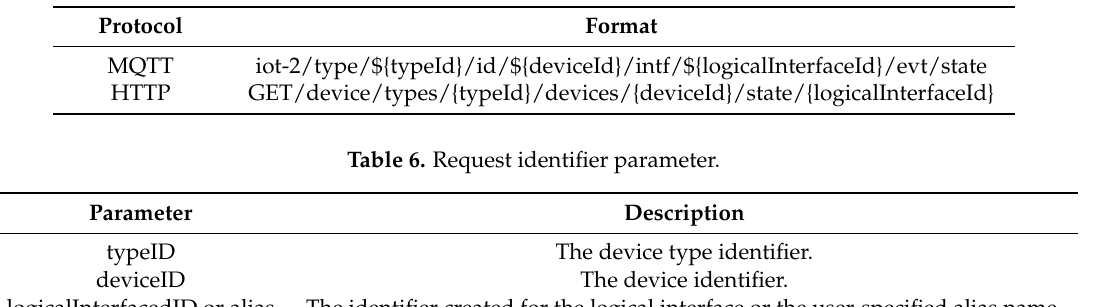
Table 5. Watson IoT resource request format.